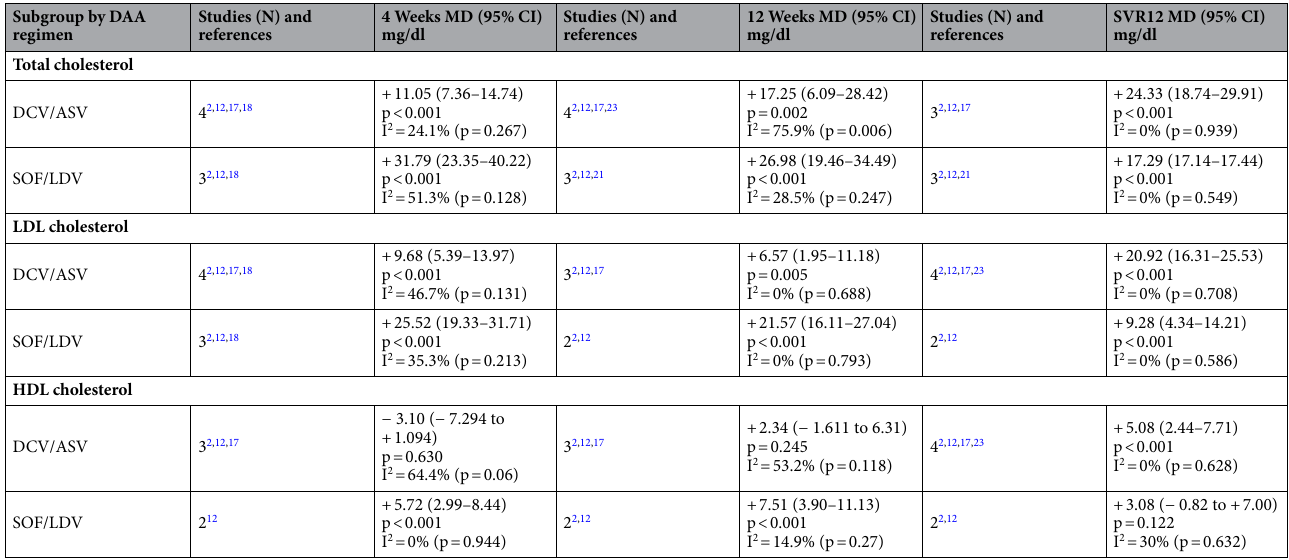
Table 2. Serum lipid changes by antiviral regimen. DCV/ASV daclatasvir/asunaprevir, SOF/LDV sofosbuvir/ ledipasvir, MD mean difference, SVR12 sustained virological response at 12